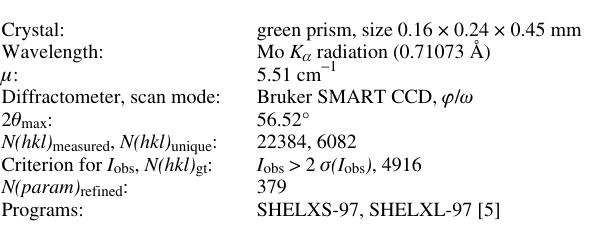
Table 1. Data collection and handling.